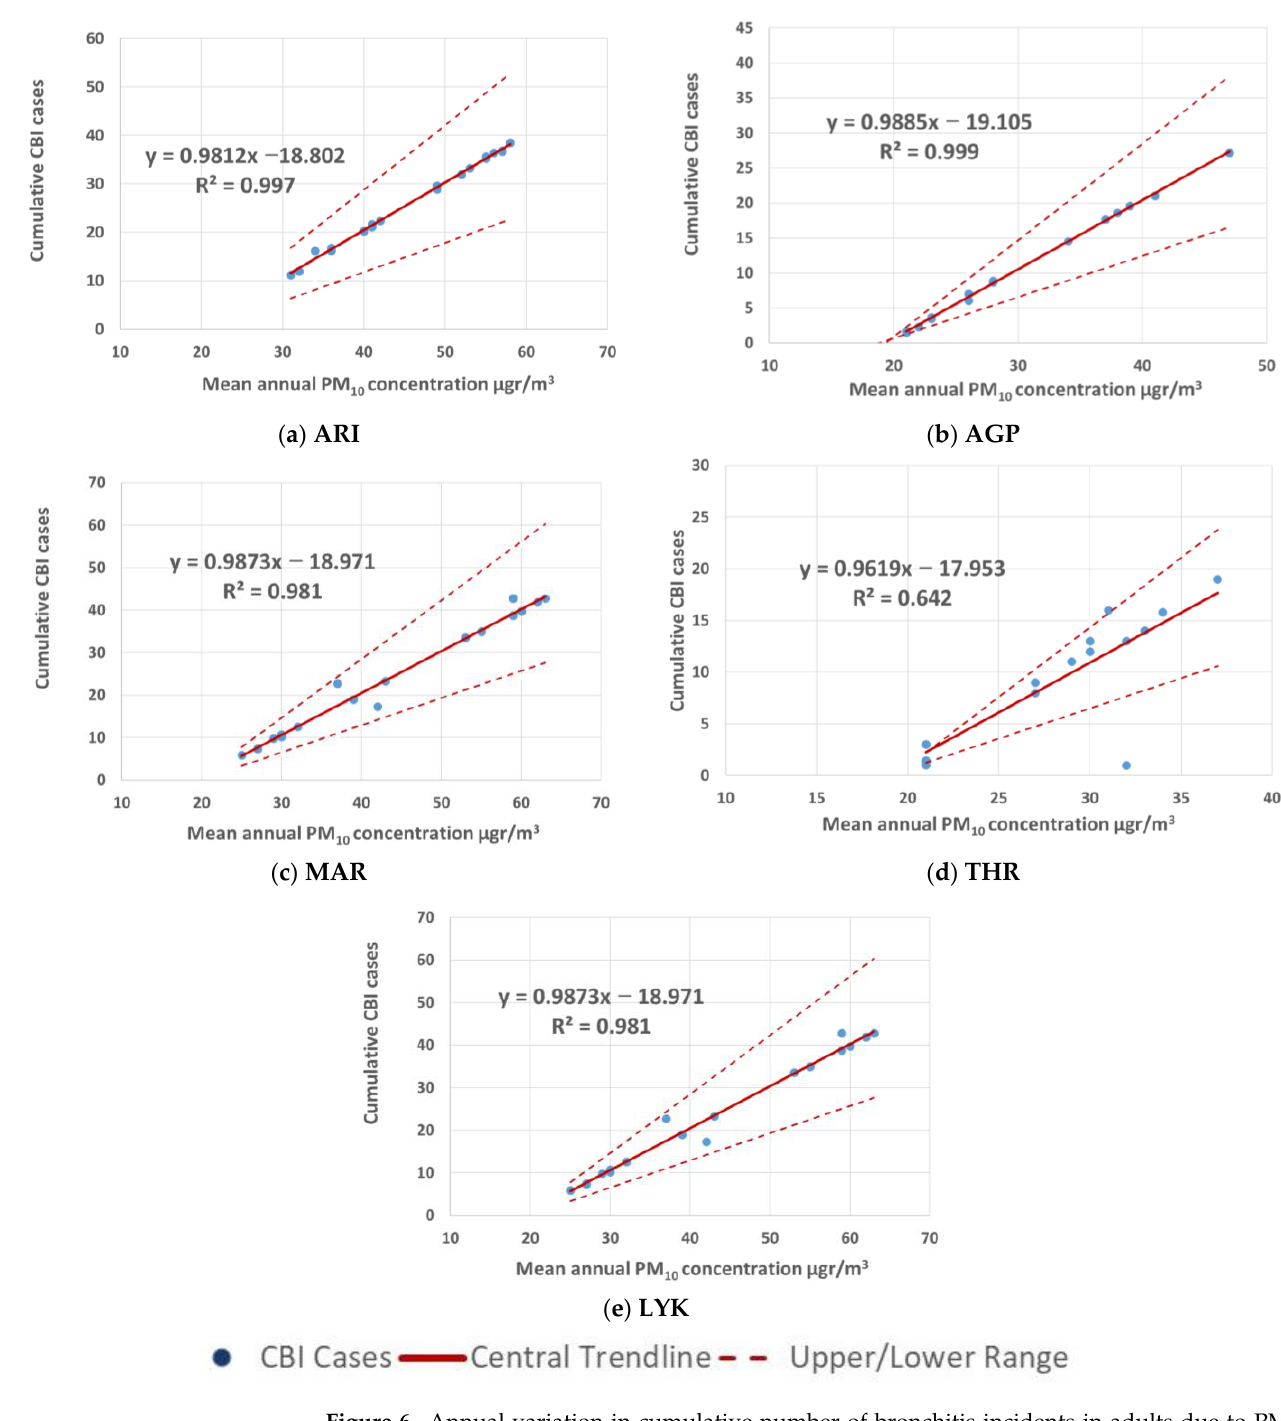
Figure 6. Annual variation in cumulative number of bronchitis incidents in adults due to PM 10 exposure vs. mean annual concentrations of all examined stations within the GAA. Period 2001–2020. (( a ): ARI, ( b ): AGP, ( c ): MAR, ( d ): THR, ( e ): LYK).